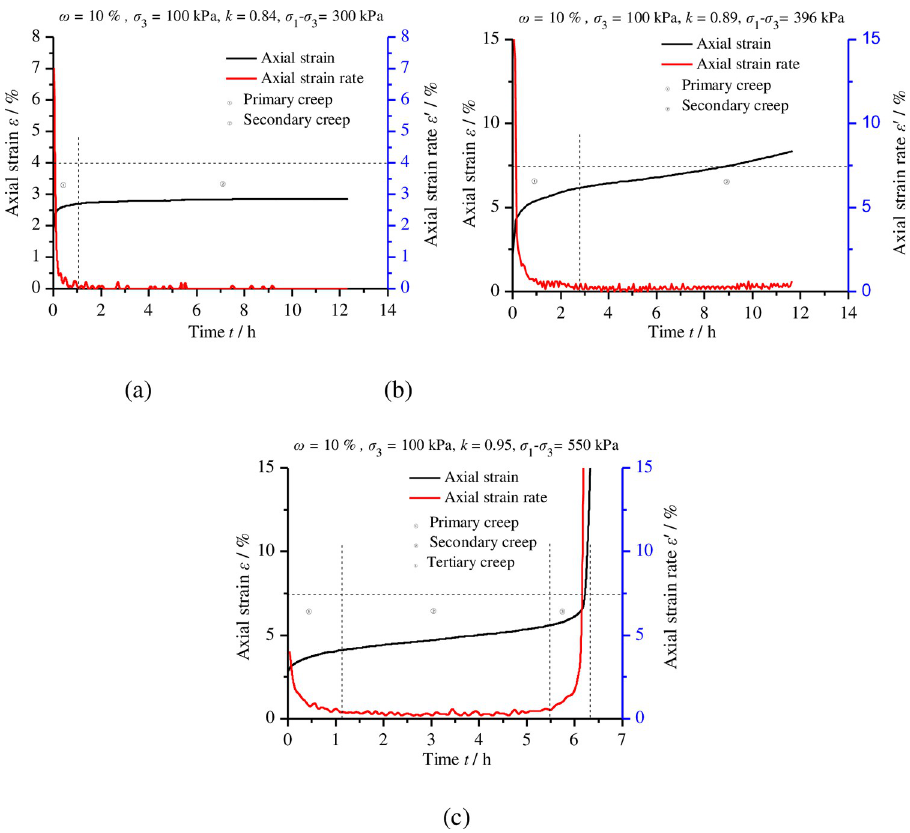
Fig 6. Relationship curves of axial strain and strain rate over time for remoulded loess under different deviatoric stress levels. (a) Compactness of 0.84 and deviatoric stress of 300 kPa; (b) compactness of 0.89 and deviatoric stress of 396 kPa; (c) compactness of 0.95 and deviatoric stress of 550 kPa.